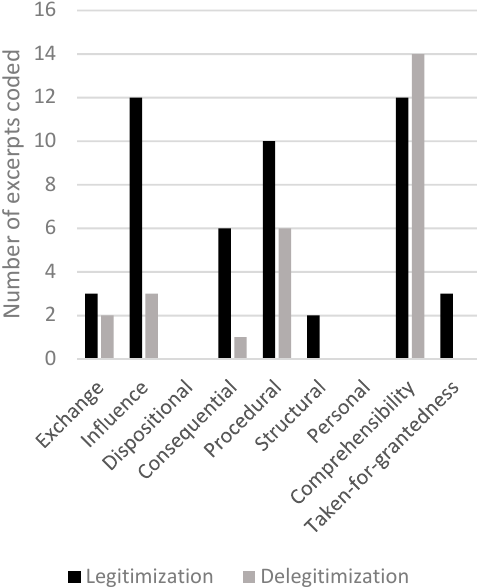
Figure 1. Frequency of legitimacy subtypes used to (de)legitimize the project of including cultural practices in the provision of water and sanitation.